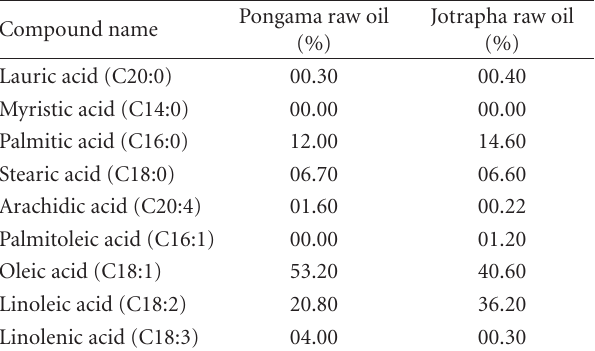
Table 1: Fatty acid composition of Pongam and Jatropha